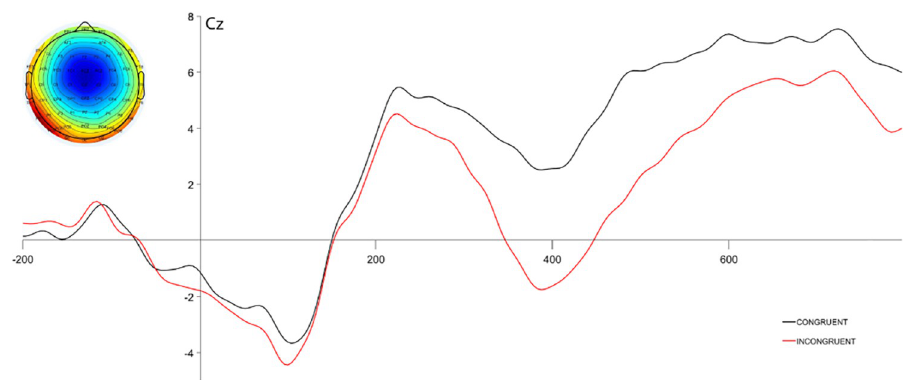
Fig 3. ERP waveform for semantic N400 paradigm observed on the CZ. Scalp map of the mean activity between 350 and 450 ms post-stimulus onset is presented in the upper left part of the figure.